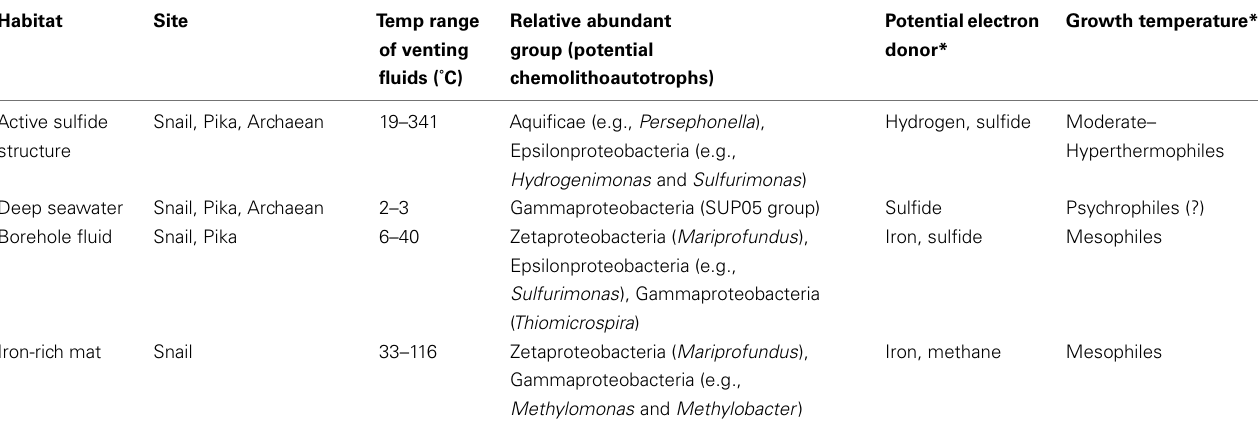
Table 1 |Abundant taxonomic groups in the bacterial clone libraries for each habitat.